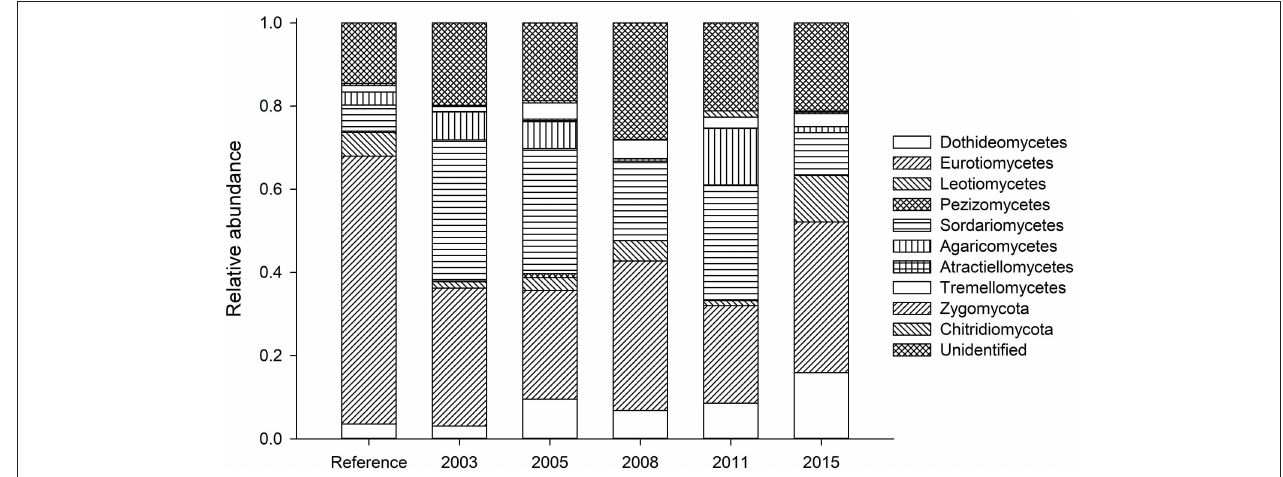
FIGURE 4 | Relative abundance of fungal phyla across the chronosequence.